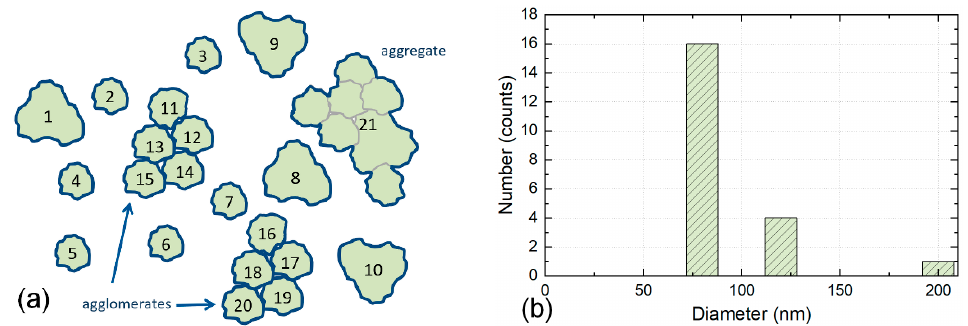
Figure 4. ( a ) Illustration of Counting Rule 3. The particles 1 to 10 are counted as individual particles. The particles which are part of the two agglomerates are counted as touching particles 11 to 15 and 16 to 20. The aggregate 21 is counted as one particle. This results in a total count of 21 particles. ( b ) Note the clear shift of the PSD towards smaller sizes. The height of the three columns in the histogram reflects the number of particles of the three sizes 80 nm (16 particles), 120 nm (4 particles), and 200 nm (1 particle). The width of the columns has no quantitative relevance and is only illustrative.